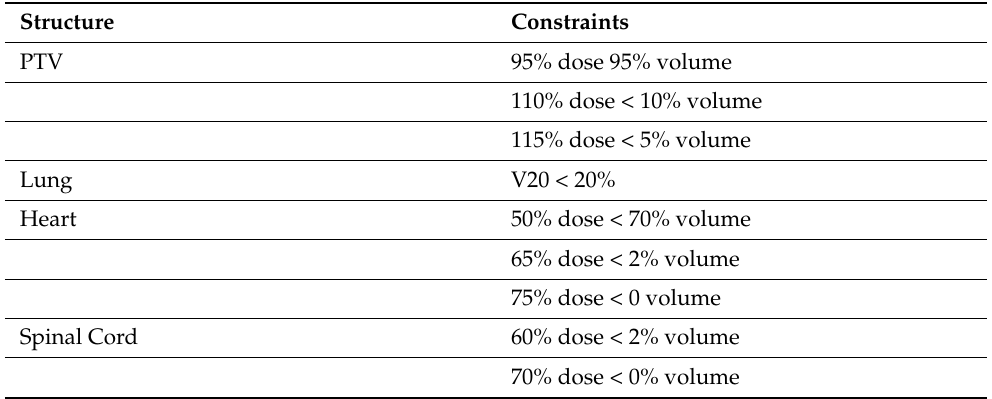
Figure 1. Lung phantom geometry for dose measurement. Slabs of pressed cork with densities of 0.25 g/cm 3 are used. The bottom cork sheet shows the detector holder and strips of cork that can be rearranged in depths and in the off-axis position. Table 1. Dose–volume constraints sent to